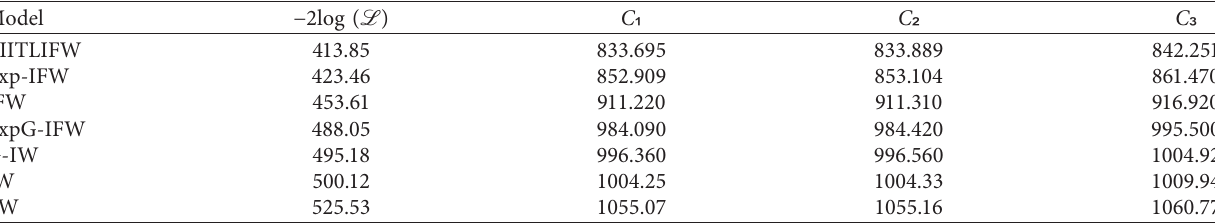
Table 5: Statistics for bladder cancer data.